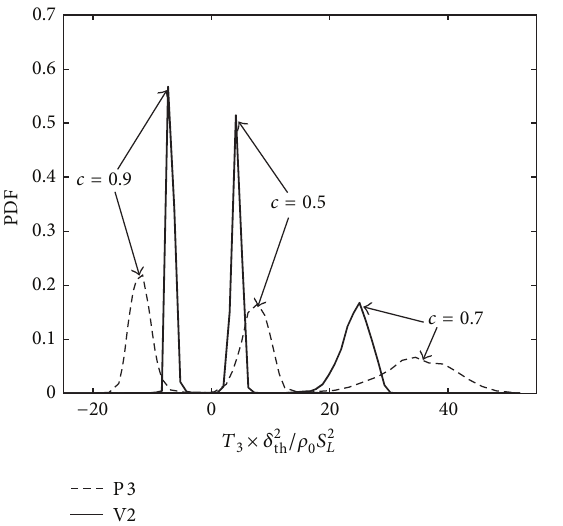
/𝜌 𝑆 2 𝑐 = 0.5 , 0.7, and 0.9 0 𝐿 for th